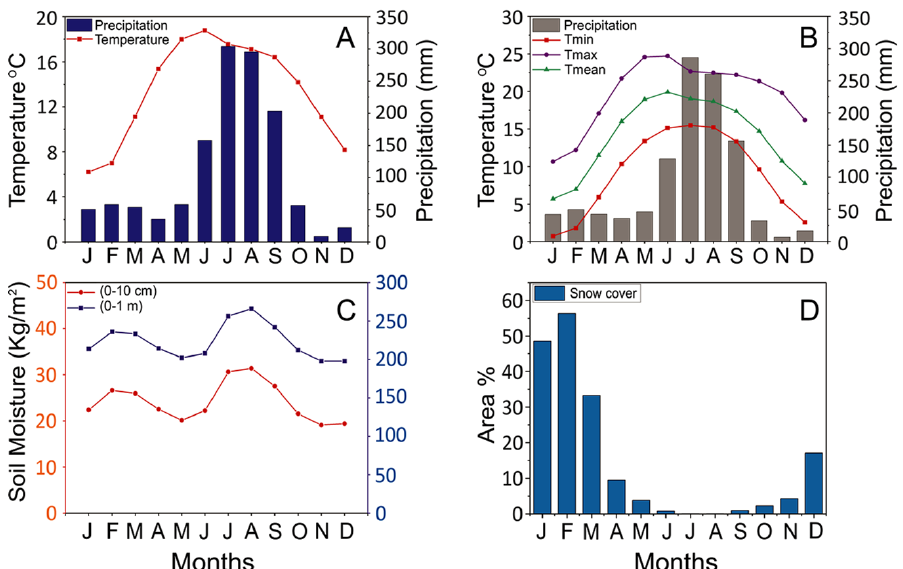
Figure 3. Mean monthly climate (temperature and precipitation) conditions of ( A ) Mukteshwar meteorological station (1960–2019 CE), ( B ) CRU ‐ TS gridded data (1960–2019 CE). Mean monthly conditions of ( C ) soil moisture (ERA ‐ Interim 1979–2016 CE) and ( D ) snow cover (ERA5; 1981–2019 CE).